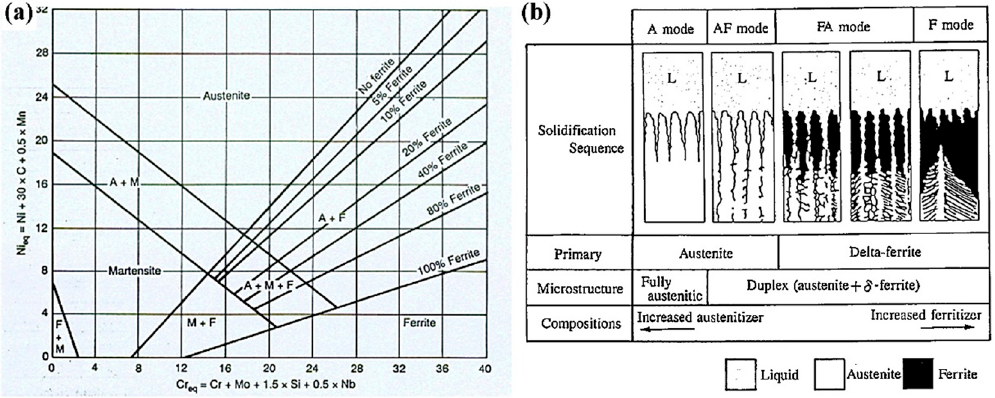
Figure 9. ( a ) Schaeffler’s diagram and ( b ) austenitic steel solidification diagram [41].